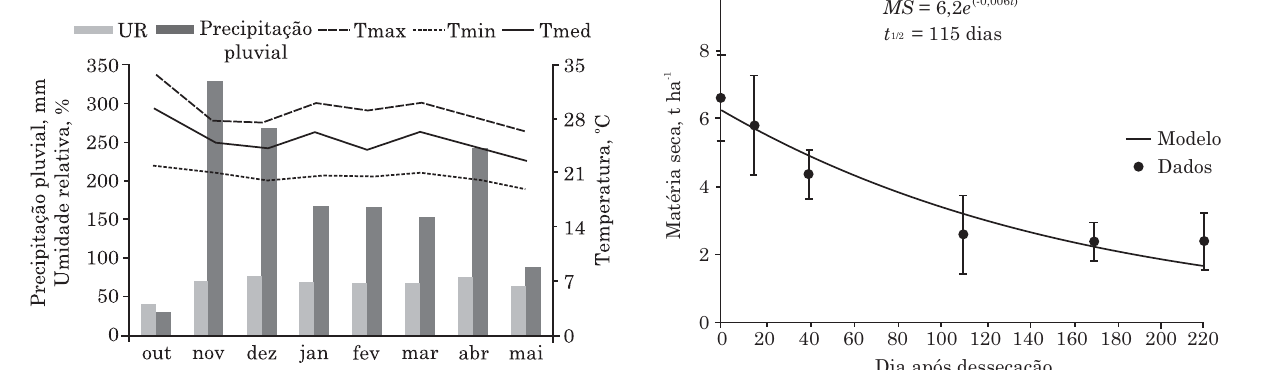
Figura 2. variação na massa de matéria seca de cobertura do solo em função de dias após a desseção das plantas com herbicida. Barras verticais representam o desvio-padrão da média de cada